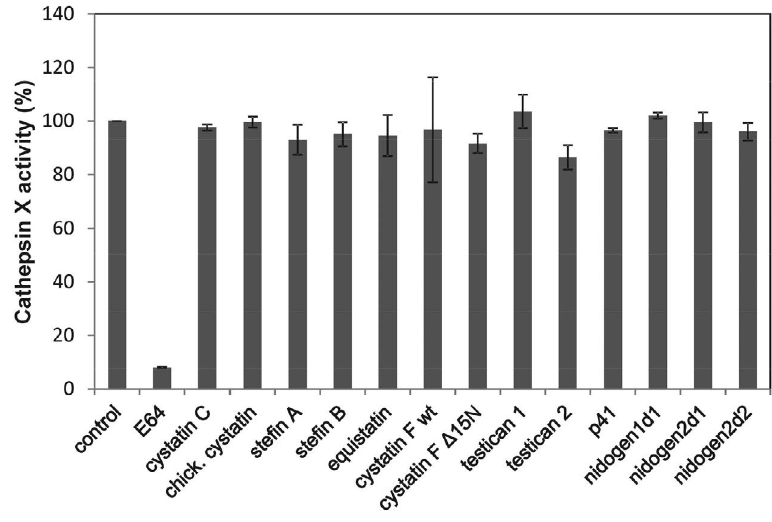
Figure 1: Cathepsin X is not inhibited by endogenous peptidase inhibitors. Relative inhibition of cathepsin X by various inhibitors was tested in a kinetic assay. Concentrations of endogenous inhibitors were 2 µM (100-fold higher than that of the enzyme), while E-64 was tested at 10 µM concentration. Assay buffer was used in a control experiment. Values are the means of two or three independent experiments, each performed in duplicate ±